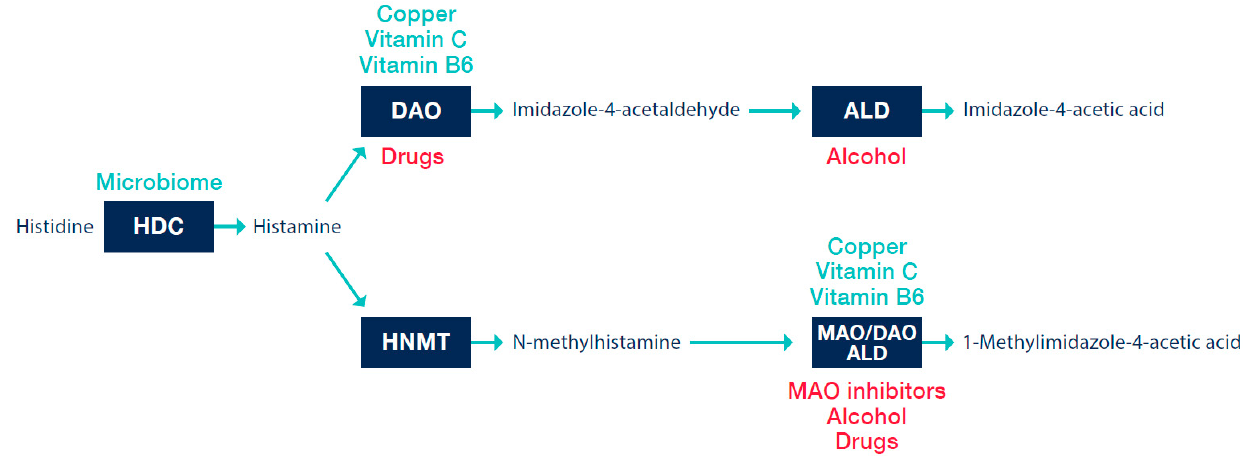
Figure 2. Histamine metabolism in vivo. HDC—histidine decarboxylase; DAO—diamine oxidase; ALD—aldehyde dehydrogenase; HNMT—histamine-N-methyl transferase; MAO—monoamine oxidase. The green are factors potentiating an endogenous capacity of enzymatic reaction. The red are factors directly/indirectly inhibiting an enzymatic reaction. Adapted according to [9,13,21,27].